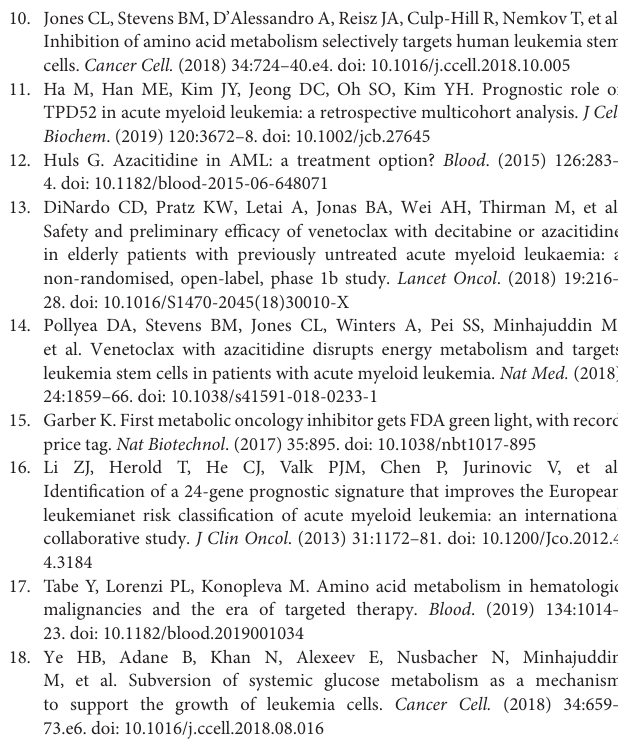
Supplemental Figure 3 | Kaplan–Meier curve of the metabolic risk model in the younger population ( ≤ 65 years) of the training cohort (A) and adult external cohort (B) . Supplemental Figure 4 | Metabolic risk score of the paired AML samples at diagnosis and relapse in TARGET dataset. Supplemental Table 1 | Correlation between clinicopathological characteristics and metabolic risk level in training cohort, adult external cohort, and pediatric external